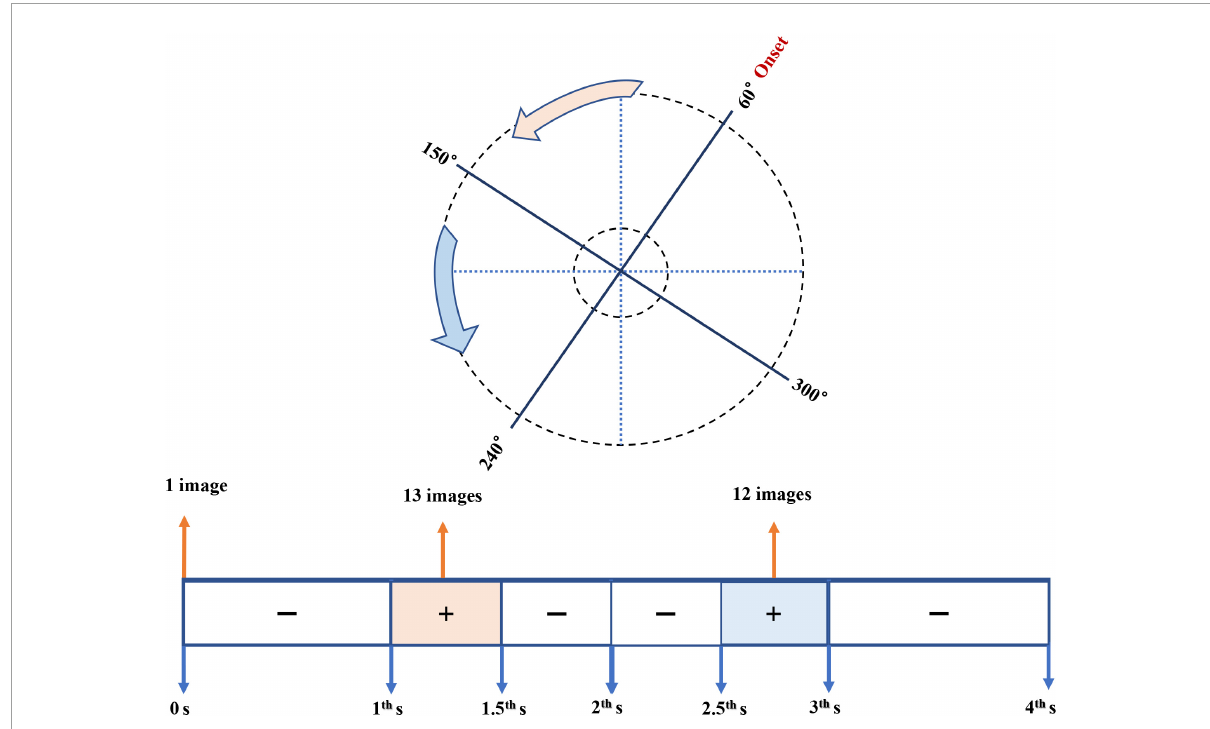
FIGURE3 Diagram of the spatial and temporal orders of collected images using Pentacam. The upper plot showed the spatial order on the meridians centered on the apex of the cornea; the lower one referred to the temporal order along the timeline of the scan procedure. The pink and the blue parts meant the spatial and temporal sequences of the 13 Scheimpflug images and the remaining 12 ones, respectively.